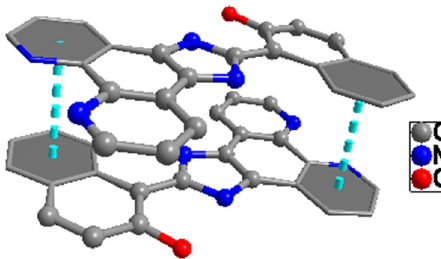
Figure 1: View of the coordination environment of the Cd ( II ) atom of 1 ( the central ring of the 1,4 - chdc is disordered over two positions, symmetric code: ( i ) x, – y + 5/2, z – 1/2; ( ii ) – x + 1, y + 1/2 , – z + 1/2 ) .